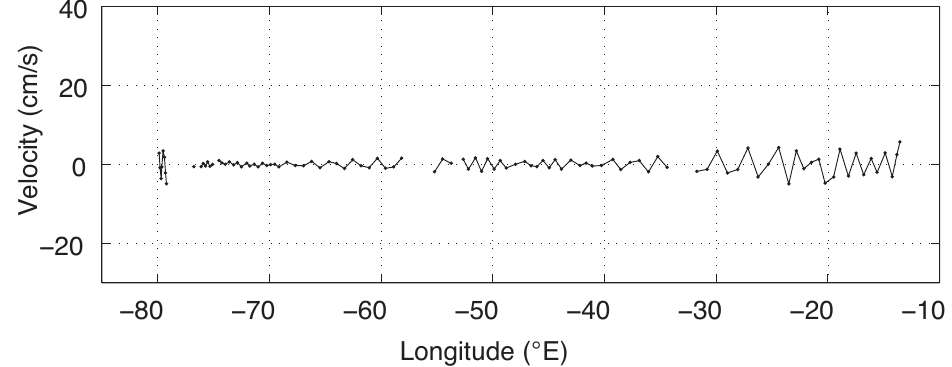
Fig . 4. – Tidal barotropic component calculated from the OSU TPXO tide prediction model. This velocity is subtracted from the velocity measurements of the LADCP and SADCP